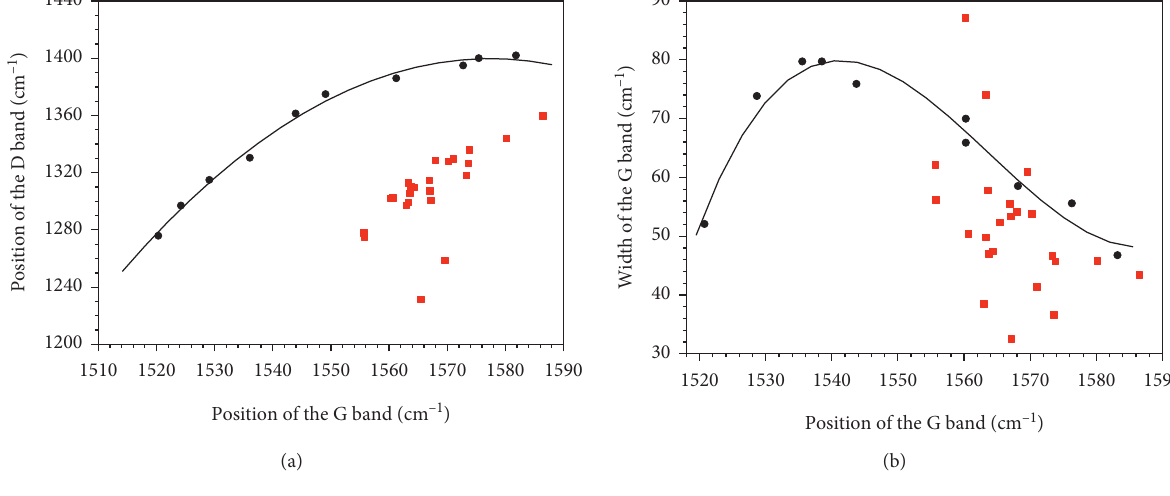
Figure 6: (a) Position of D band versus position of G band. (b) G bandwidth versus G band position; , this work; • , work from Tamor and Vassell [36].